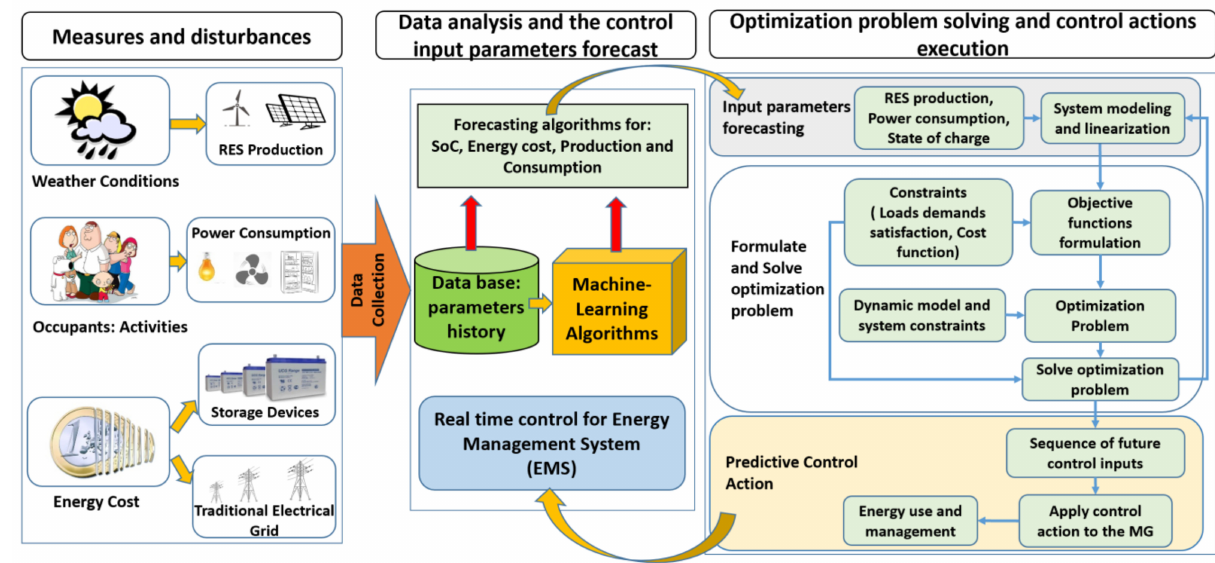
Figure 1. Energy management schemes with GPC operation processes (Reprinted from ref.